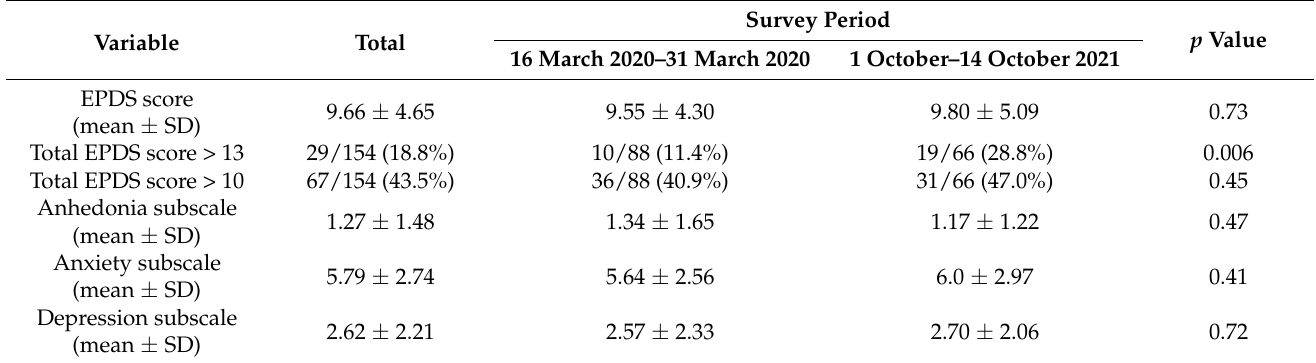
Table 2. Description of EPDS score results among the 154 participants surveyed in the two periods.